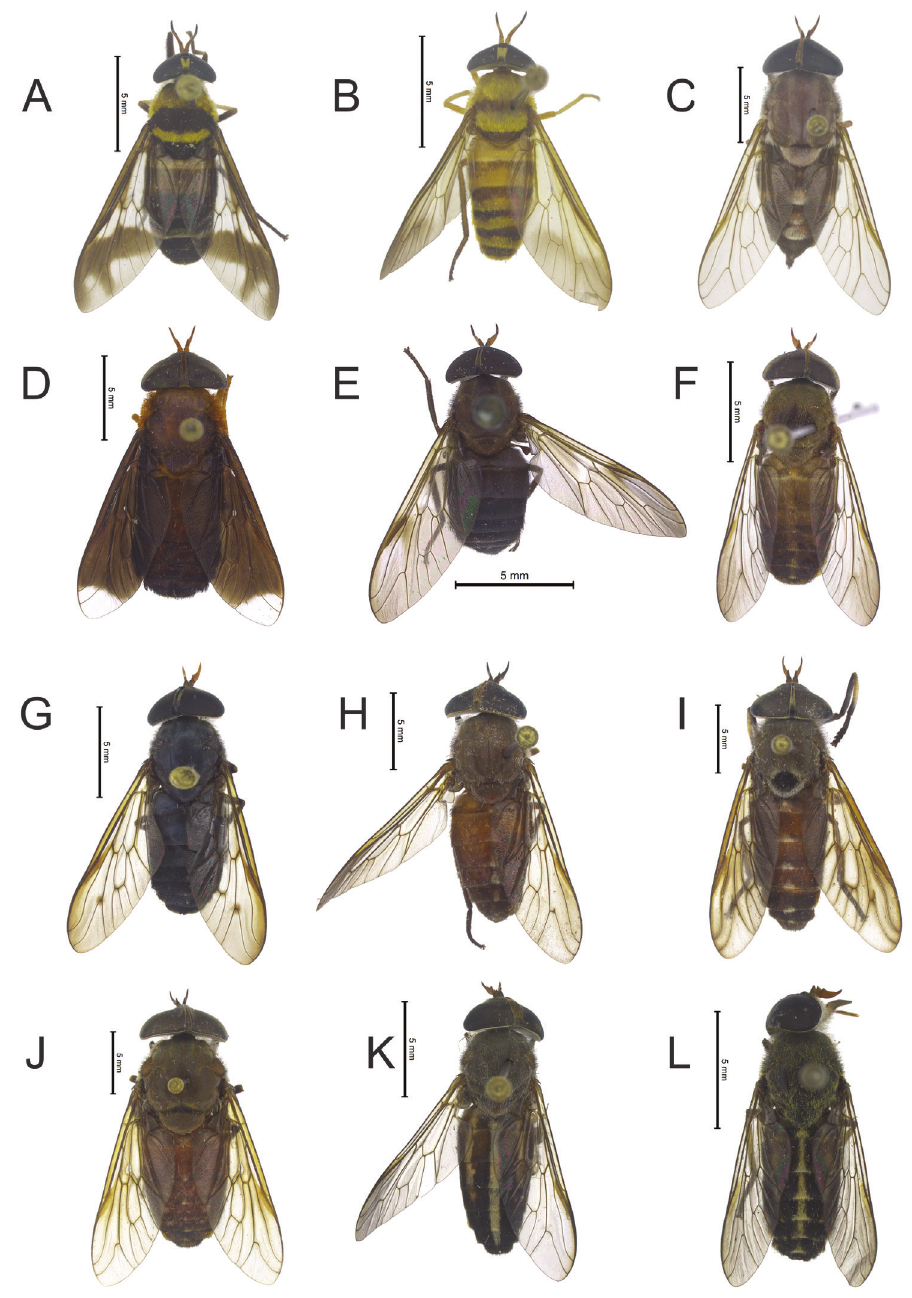
Figure 12. A Dichelacera damicornis (Fabricius) B Dichelacera marginata Macquart C Leucotabanus albovarius (Walker) D Phaeotabanus phaeopterus Fairchild E Philipotabanus stigmaticalis (Kröber) F Sty- pommisa captiroptera (Kröber) G Stypommisa modica (Hine) H Tabanus amapaensis Fairchild I Tabanus antarcticus Linnaeus J Tabanus discus Wiedemann K Tabanus occidentalis Linnaeus L Tabanus trivittatus Fabricius. Photos by Augusto